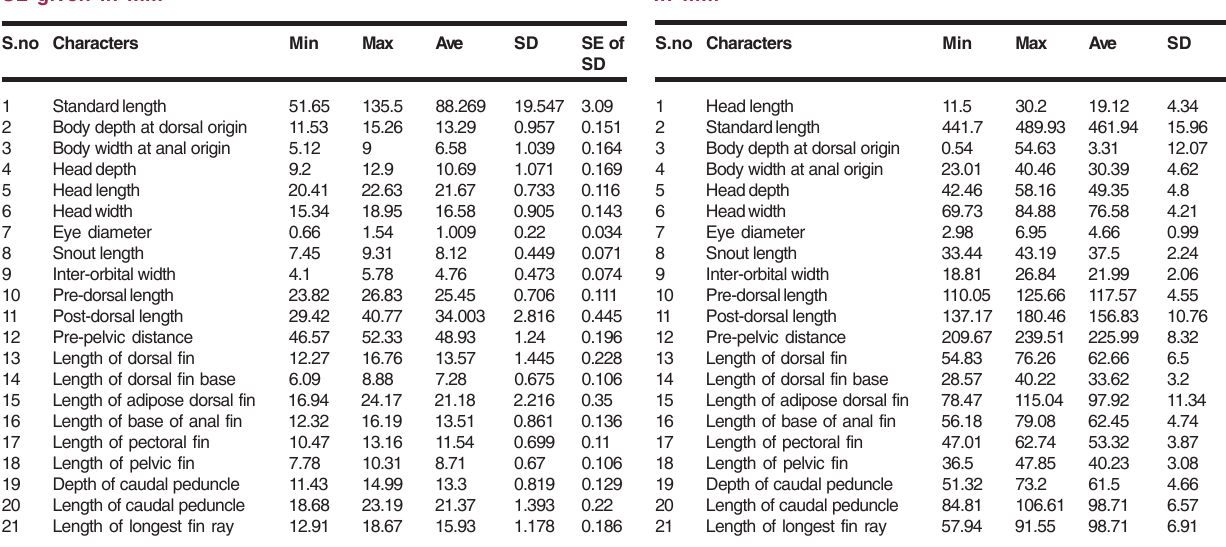
Table 5. Morphometric data of male in % HL except HL given in mm